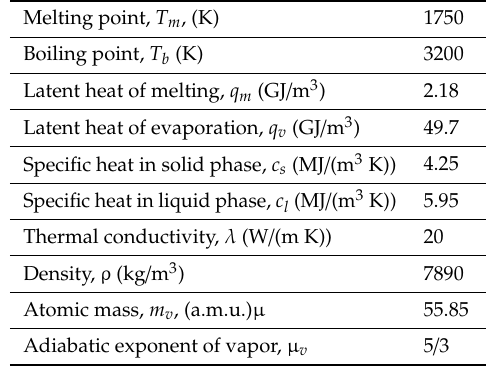
Table 1. Properties of steel Х 18 Н 10 Т accepted for modeling [30].